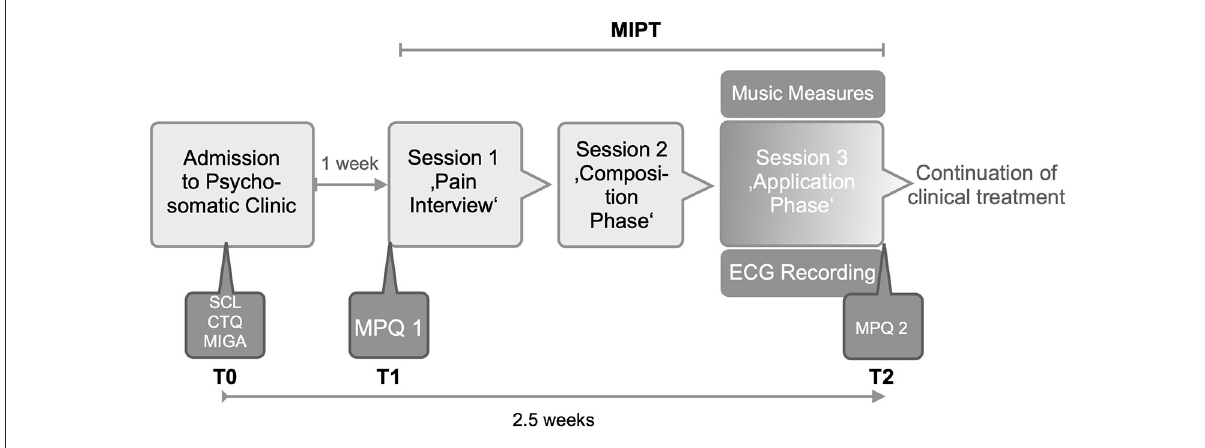
FIGURE2 Study design (MIPT, Music-imaginative Pain Treatment; SCL, Symptom Check List; CTQ, Childhood Trauma Questionnaire; MIGA, MIGA Questionnaire; MPQ, McGill Pain Questionnaire; ECG, Electrocardiogramm).